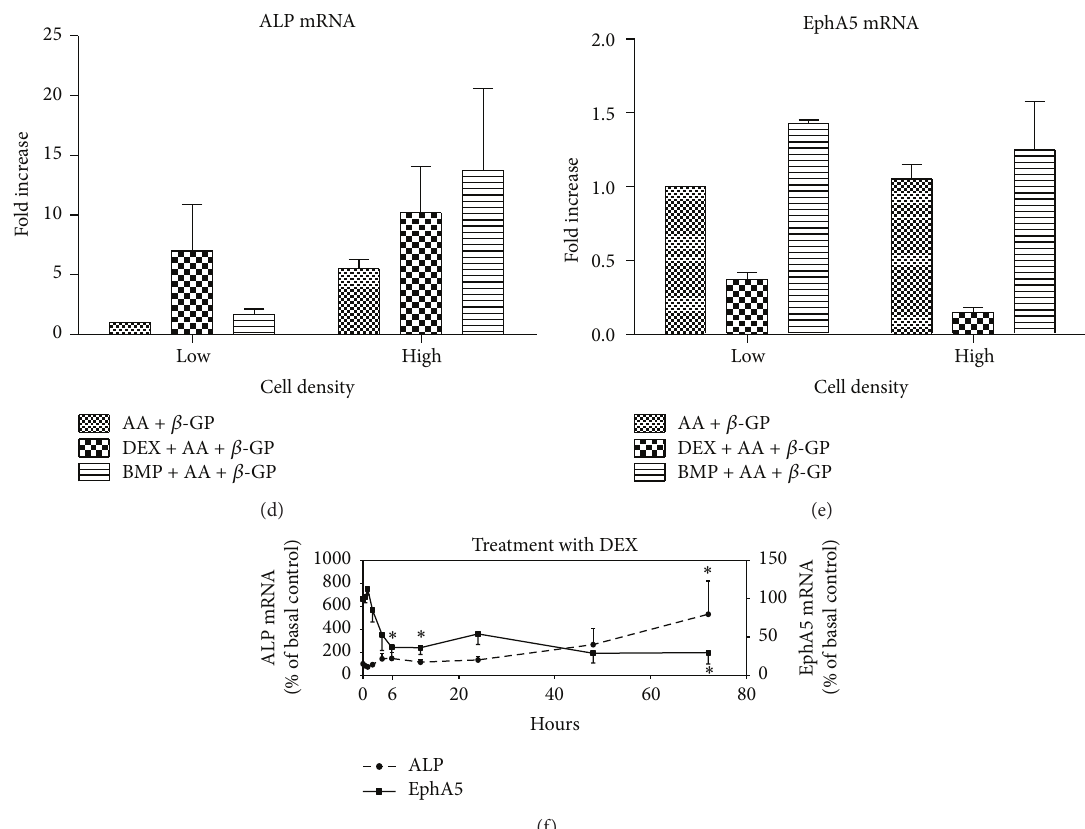
Figure 2: EphA5 is upregulated after repeated passaging and downregulated during osteogenic induction with DEX. (a) Expression of members of the ephrin and Eph receptor families in hBMSCs. P5 BMSCs were differentiated into osteogenic lineages using AA + 𝛽 -GP + DEX or BMP-2, and quantitative PCR to determine the mRNA expression of ephrin and Eph receptor family members was performed at day 3 of osteogenic induction ( 𝑛 = 8 ). The fold change of gene expression was normalized against the expression level in the nontreated culture. DEX treatment suppressed and BMP treatment increased the mRNA expression of both EphA2 and EphA5, respectively. (b) Cell surface alkaline phosphatase (ALP) expression in hBMSCs at passage 5 was analyzed using flow cytometry (left, 𝑛 = 4 ). Positive expression was defined as a level of fluorescence higher than 97% of the fluorescence obtained with the corresponding isotype-matched control antibody. Positive expression rates are displayed as the mean ± SEM (green line, isotype control). DEX-treated cells showed a higher positive rate for ALP expression than untreated cells ( ∗ 𝑝 < 0.05 ). Cell bodies became smaller and showed morphological changes at day 14 of DEX treatment (right, magnification × 40). ((c)–(e)) Effect of cell density on ALP and EphA5 mRNA levels under different osteogenic induction protocols. (c) hBMSCs at P5 were seeded at low cell density, without intercellular contact, or at high cell density, that is, almost at confluency. # shows intracellular contact between P1 and P5 cells. ((d), (e)) Quantitative analyses of (d) ALP and (e) EphA5 mRNA expression. The fold change of gene expression was normalized against the expression in cultures at low density with AA and 𝛽 -GP treatment ( 𝑛 = 4 ). (f) Quantitative analyses of ALP and EphA5 mRNA expression in BMSCs at passage 5 when treated with DEX. The change in the expression of each gene expression was normalized against the expression in cell cultures prior to DEX addition ( 𝑛 = 9 ). EphA5 expression was transiently reduced after 2 hours of DEX induction and reached a minimum value after 6h of induction. ALP expression was induced after 24 h of DEX induction, after which EphA5 expression gradually decreased